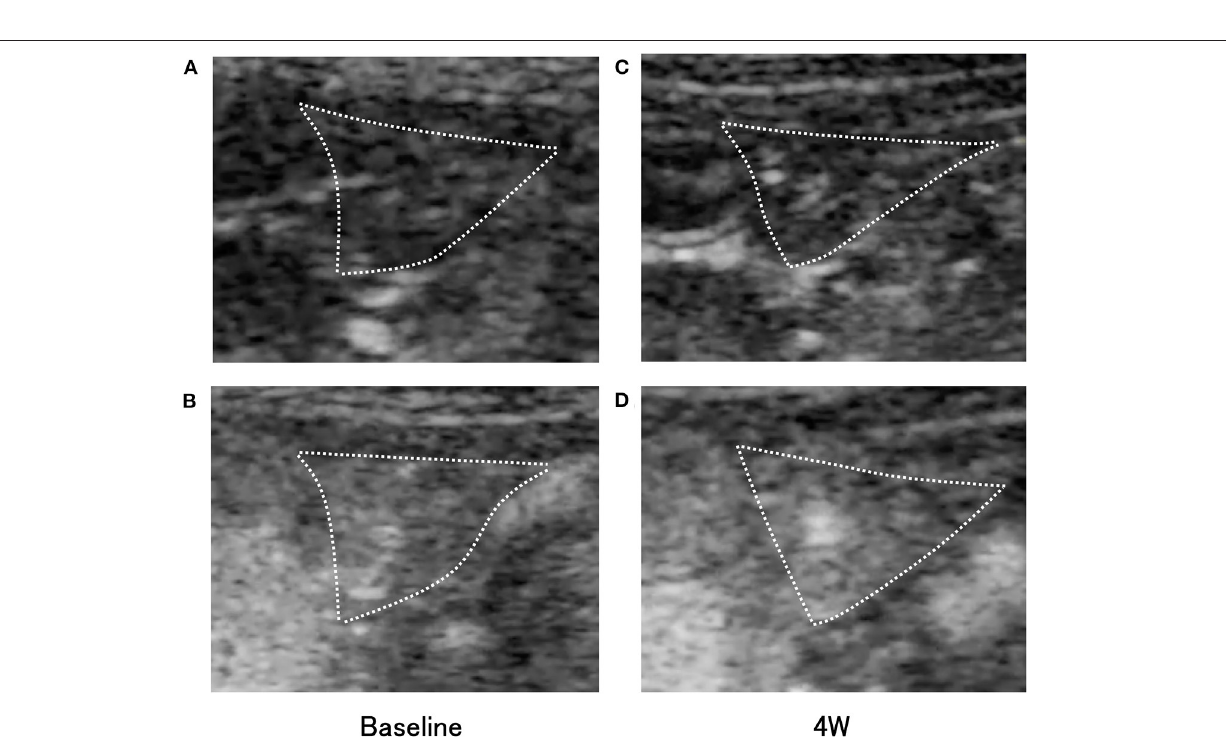
FIGURE 2 | Transverse contrast-enhanced ultrasonography (CEUS) images of the right pancreatic lobe (outlined by dotted lines) in the pimobendan group. (A,B) show the intensity increase in the pancreas with contrast agent before initiating rapid ventricular pacing (baseline). (A) Just after initiation of contrast imaging. (B) Peak of intensity increase. (C,D) show the intensity increase in the pancreas with contrast agent at 4 weeks after initiating rapid ventricular pacing (4 weeks). (C) Just after initiation of contrast imaging. (D) Peak of intensity